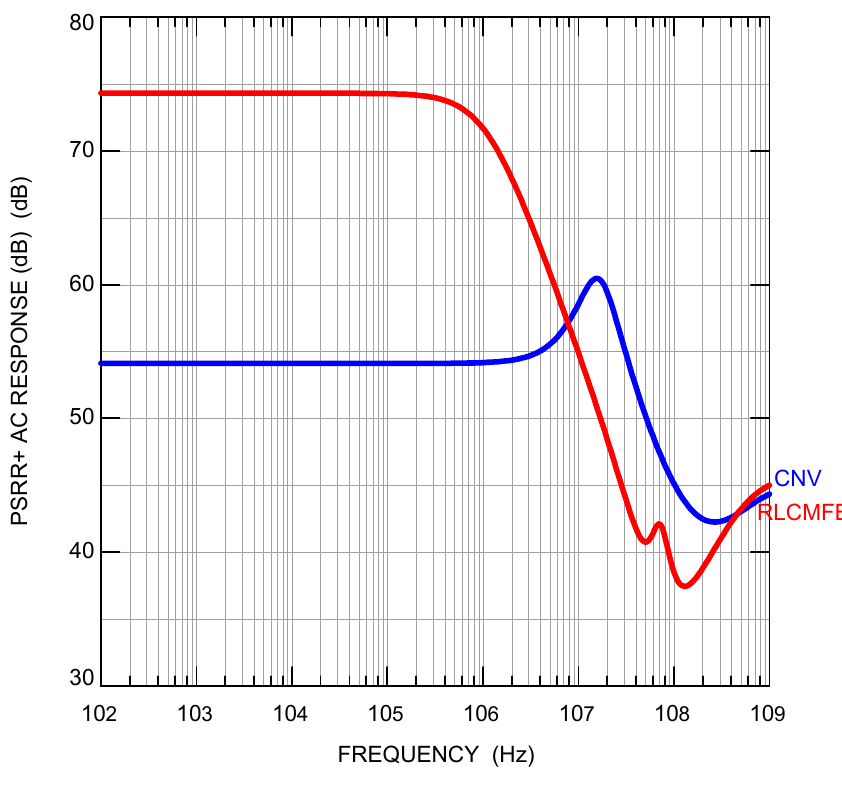
Figure 7. CMRR response of circuits of Figure 3.